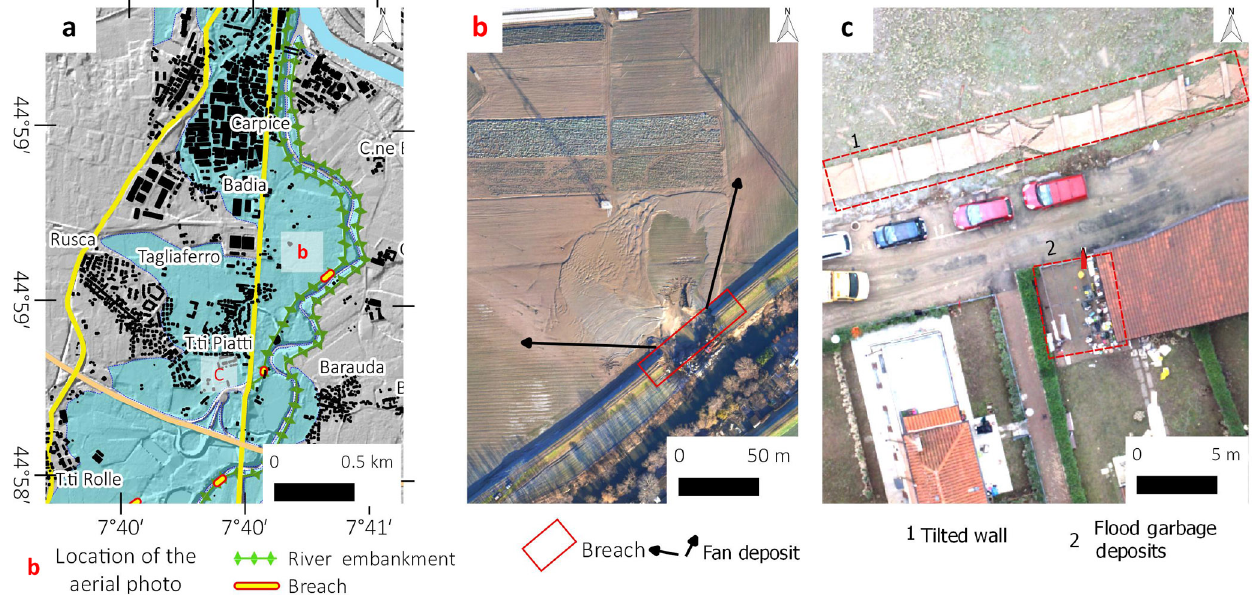
Figure 8. (a) Map of areas flooded by Chisola stream in Moncalieri municipality with location of detailed photo; (b) aerial photo at 0.1m of resolution showing the breach of river embankment and the “alluvial fan” created by water flow showed with a 3-D view in Fig. 9; (c) RPASs photo at 0.02m of spatial resolution showing a collapsed wall in the Tetti Piatti area and a deposit of damaged goods from the nearby